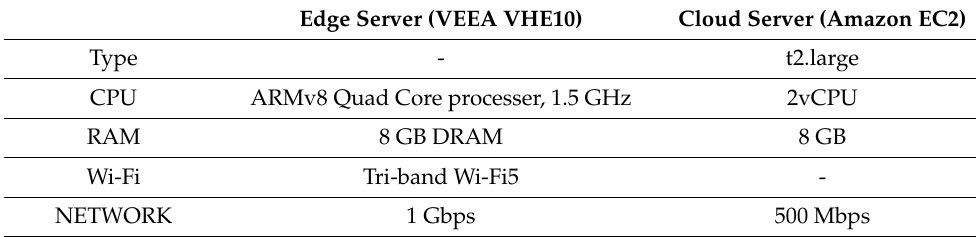
Table 2. Server information used in the experiment.